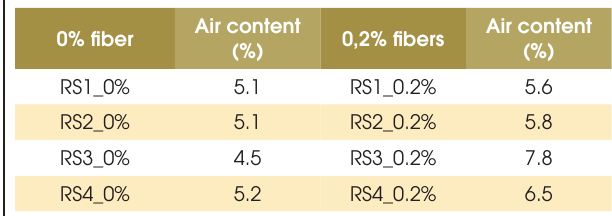
Table 2 – Air content of the mortars prepared by different mixing sequences